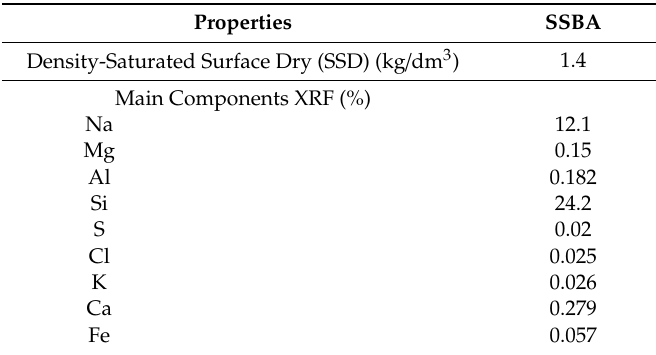
Table 2. Physical and chemical properties of SSBA.